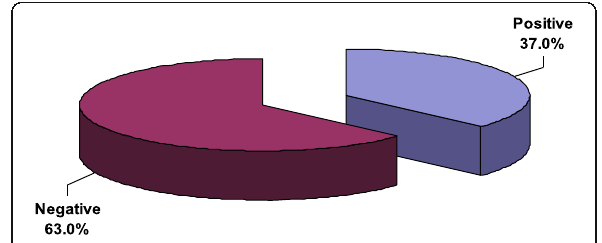
Fig. 3 History of positive family contact among affected students, Tema District, Sohag, Egypt